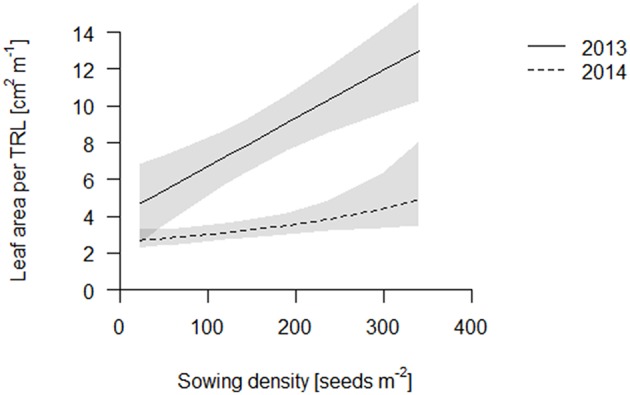
Leaf area per total root length (TRL) of the coring in 2013 (solid line) and 2014 (dashed line). Data are presented as best fits with 95% confidence interval (gray). For equations, R2 and p-values see Table S2.